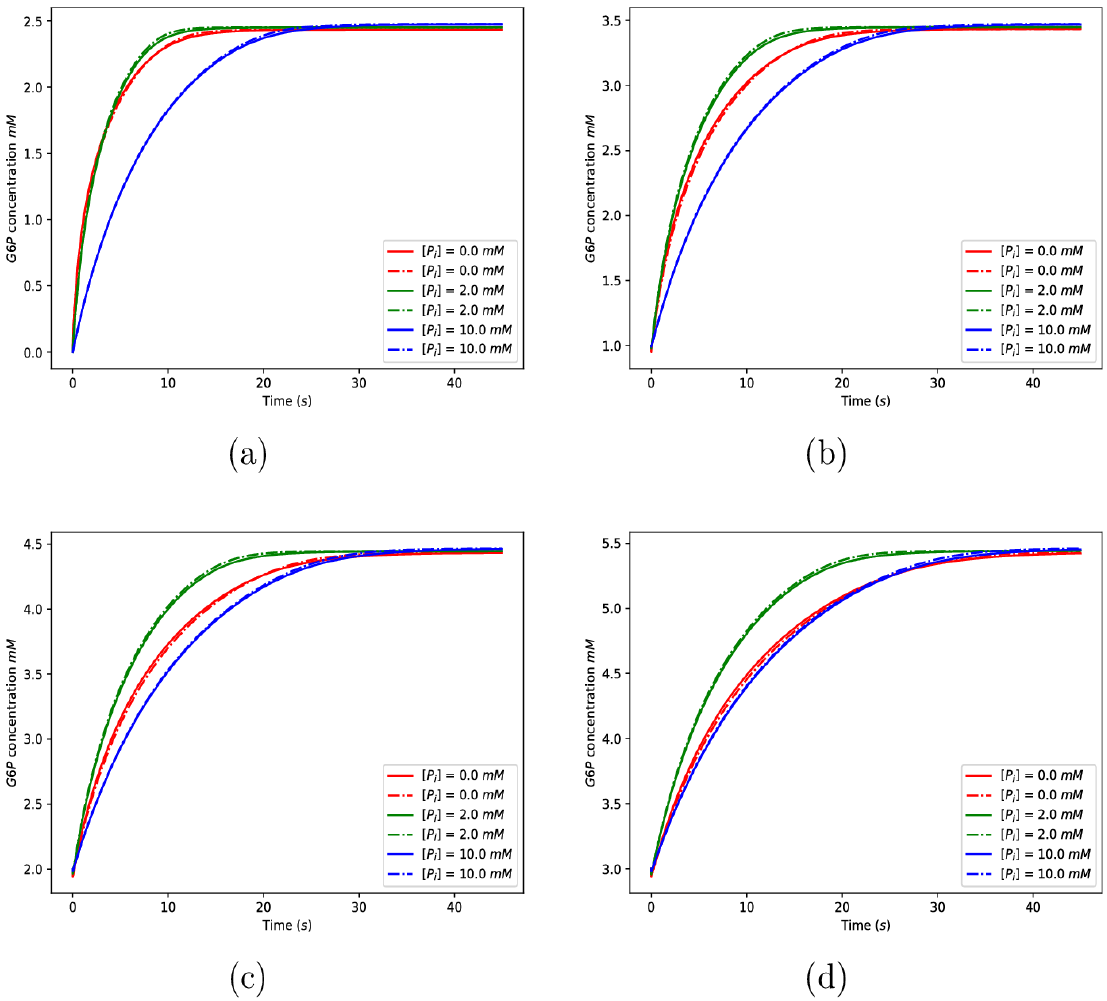
Figure 12. Comparison of the numerical solutions to the full model and the simplified model (SM). The solid curves are solutions to the full model, and the dashed-dotted curves are solutions to the SM. The initial concentrations for the phosphate P i are given on the figures, and the initial concentrations for G 6 P are given by ( a ) 0 mM, ( b ) 1.0 mM, ( c ) 2.0 mM, and ( d ) 3.0 mM. The remaining parameter values used can be found in the main body of the